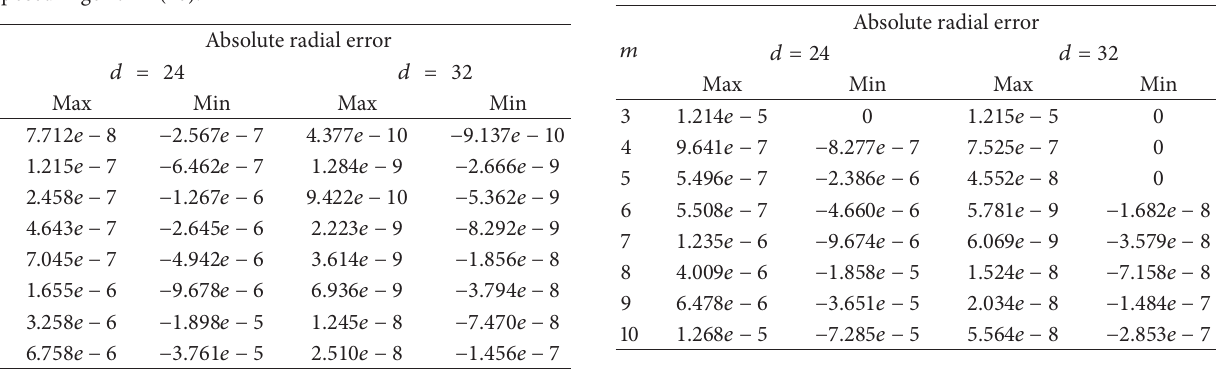
Figure 6: Number of correct bits of result as a function of 𝑚 at 𝑅 = 2 𝑚 and 𝑑 = 32 . Table 5: Maximum values of the absolute radial error ( 𝑅 = 2 𝑚 ) for Algorithm